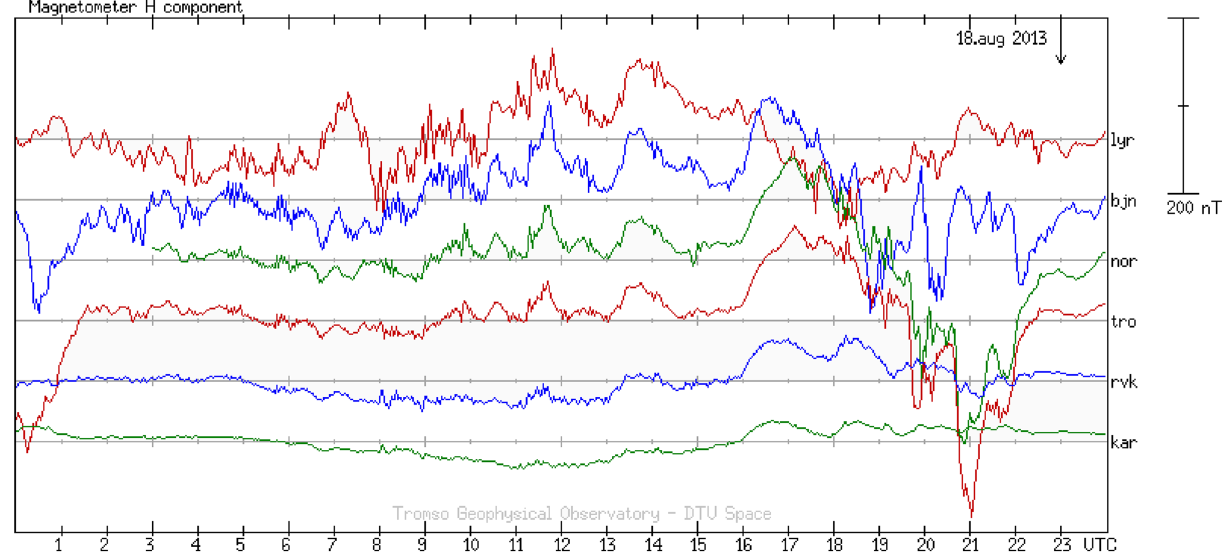
Fig. 11. Traces of the H-component of the geomagnetic fi eld recorded on 18 August 2013 by a selection of magnetometer stations from the Norwegian chain. From top to bottom these are, along with their geomagnetic latitudes (2004, altitude 100 km): Longyearbyen (75.31 (cid:3) N), Bjørnøya (71.52 (cid:3) N), Nordkapp (67.87 (cid:3) N), Tromsø (66.69 (cid:3) N), Rørvik (62.28 (cid:3) N), and Karmøy (56.43 (cid:3) N).